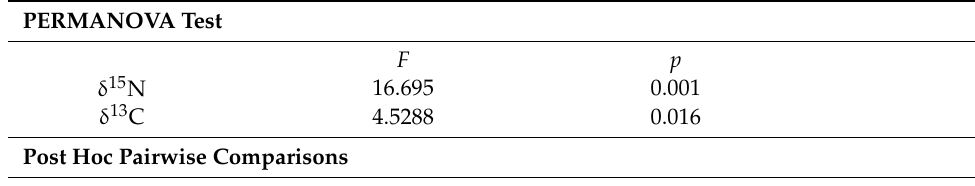
Table 2. Summary of PERMANOVA test and post hoc pairwise